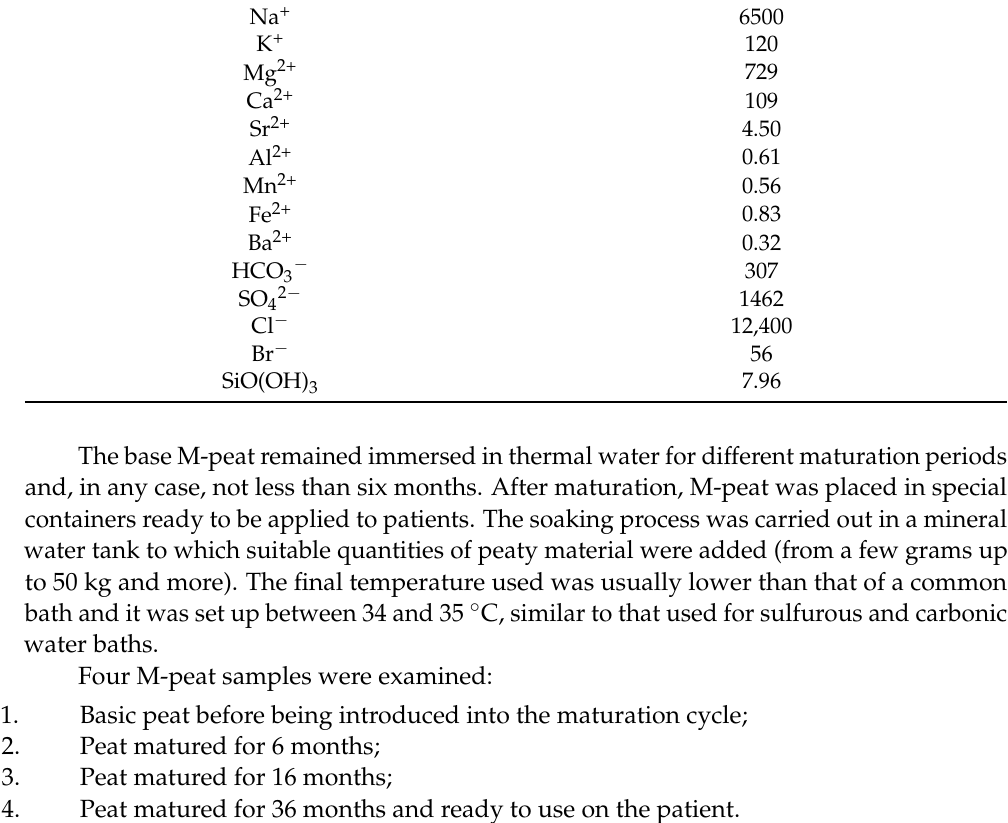
Table 1. Analysis of the water used in the maturation of peat. Ions Mg/L Na + 6500 K